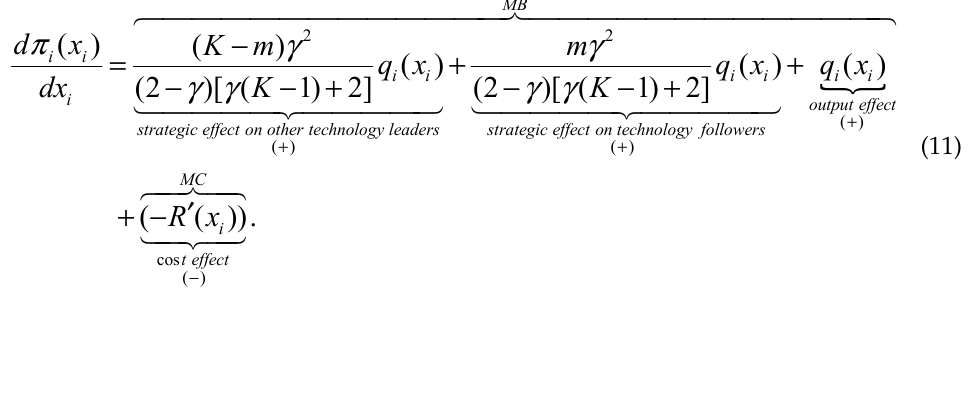
∂ W < 0. If follows from Figure 5 that a ( a − c ) ∂γ